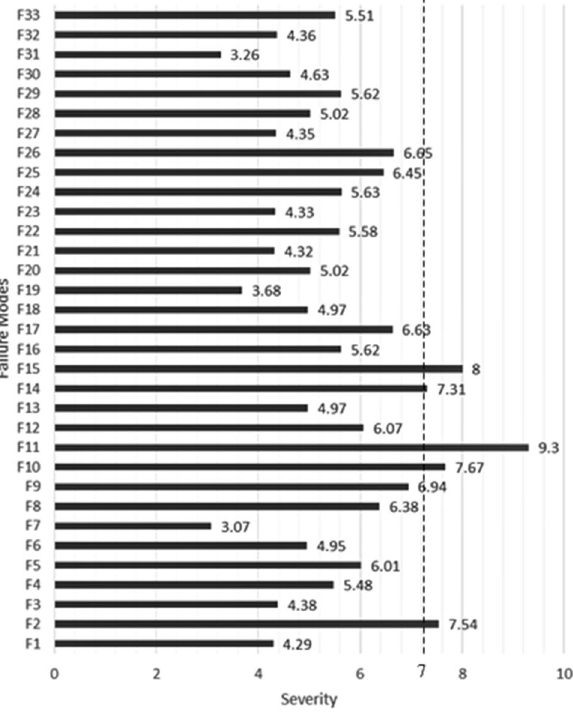
Fig. 4 Comparative chart of "Severity" values